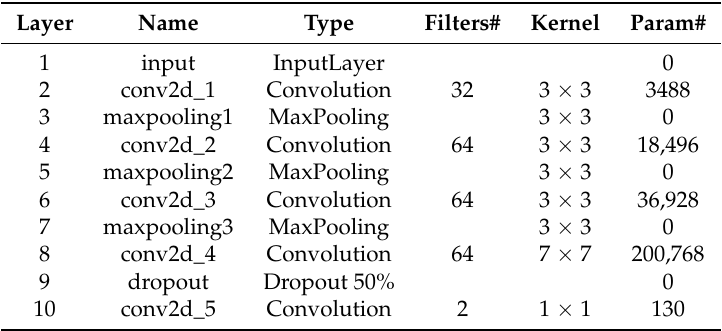
Table 2. Mine and dam discovery model summary (# means